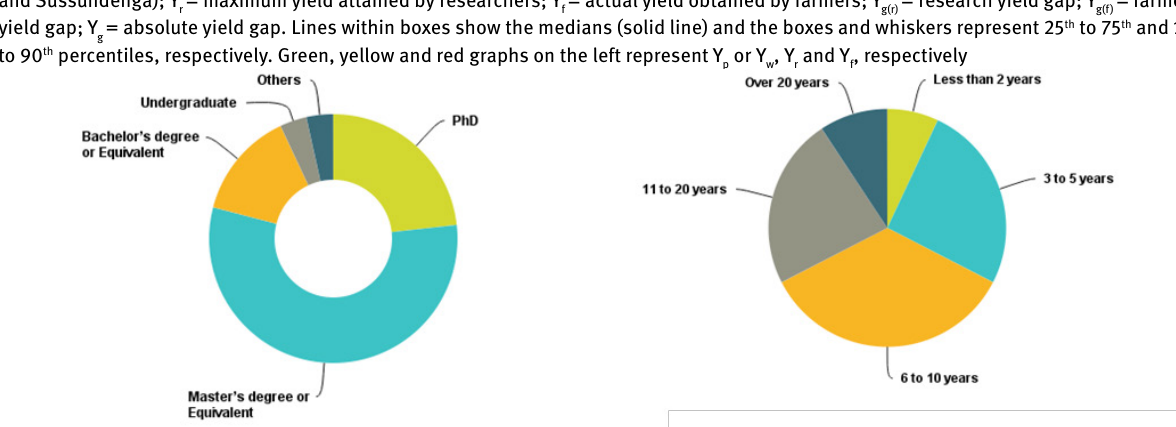
Figure 3: Biographic information on respondents: education level (left) and length of work experience with potato in SSA